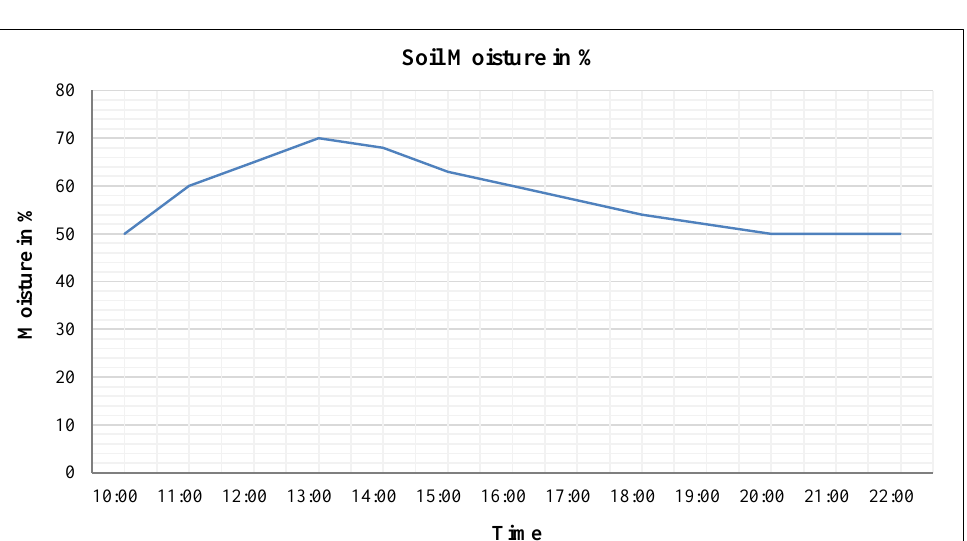
Figure 17. Time vs. Humidity